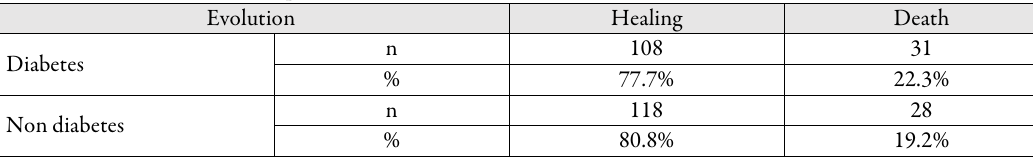
Table 5. Distribution of patients by clinical